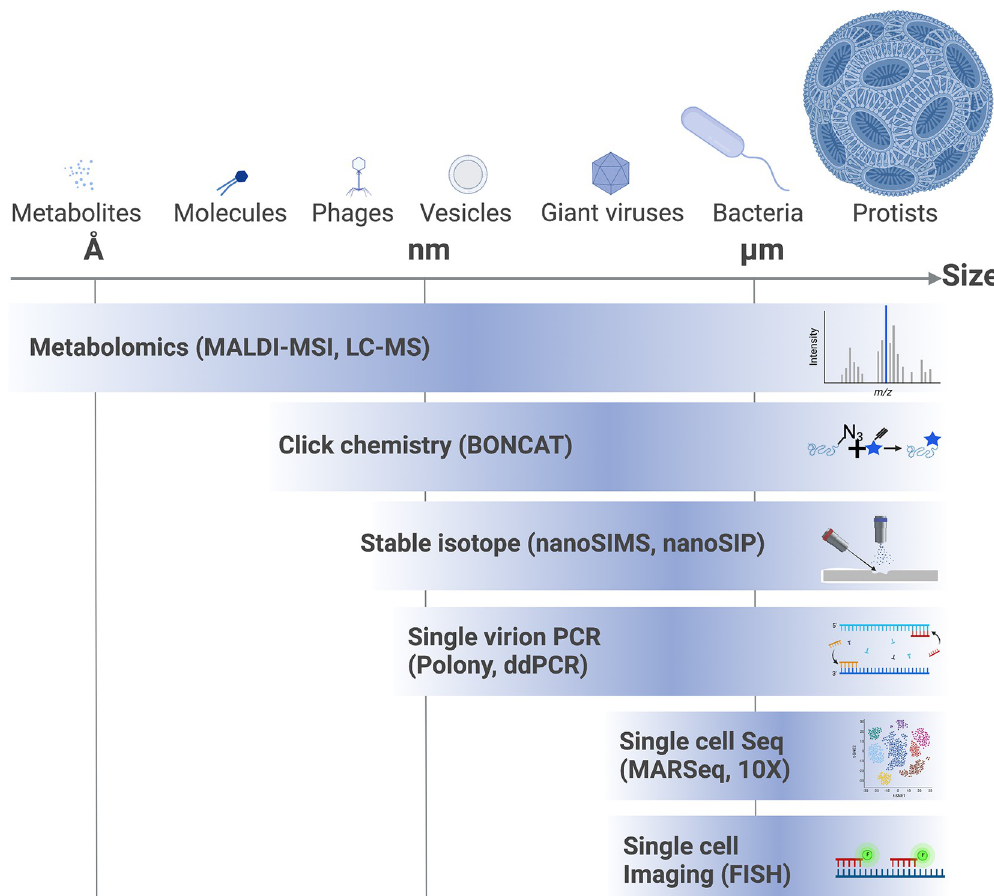
Fig 1. Approaches to track viral infection at the microscales. New technologies have largely contributed to a better understanding of viral infection at the micro- and nanoscales, including high-resolution mass spectrometry, in situ hybridization techniques, and high-throughput single-cell imaging and sequencing methods. Current approaches enable us to visualize the spatial organization of metabolites and macromolecules in infected cultures, to detect newly synthesized viral proteins, and to define the infection state of individual cells. Beyond methodological tour de forces , these often lead to concepts unthought of before, because they were unseen. Created with